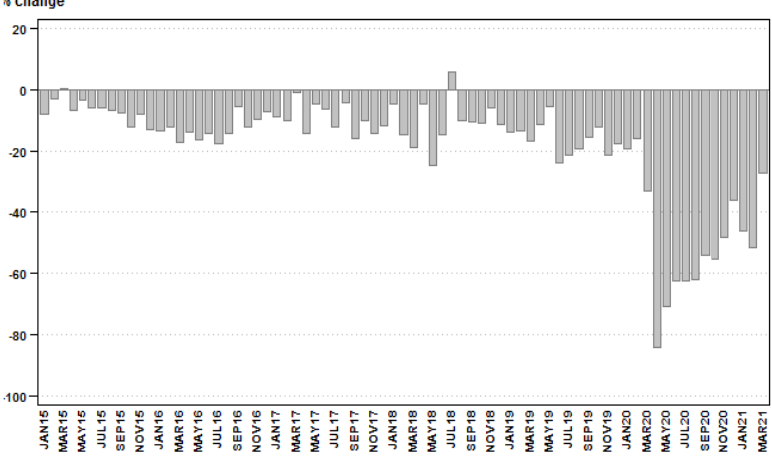
Figure 1: Passenger transportation: year-on-year percentage change in passenger journeys; Source: Stats SA (2021) During 6 years, spanning between 2015 and 2021 exchange fluctuated from 11.57 USD-ZAR to 15.00 USD-ZAR (NEDBANK, 2021). Within the same period, the petrol price increase from R 11.24 per litter to R 18.10 (Petroleum, 2021) while the